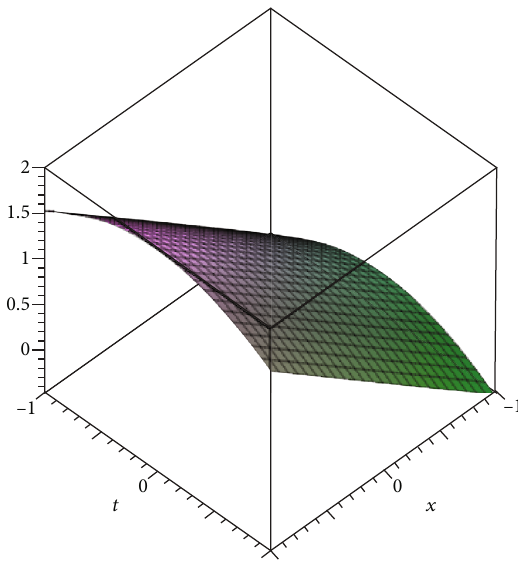
Figure 4: For u 1 ð x , t Þ = log ð x + t Þ − s , s = 0 : 00001 . Figure 5: For u 3 ð x , t Þ = ð x − s Þ + cos ð t Þ , s = 0 : 00001